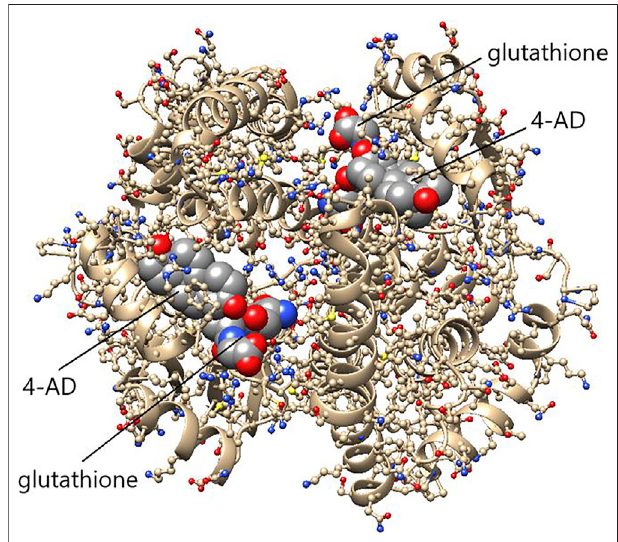
FIGURE8| Structure oftheef fi cientketosteroidisomeraseHsaGSTA3- 3 in a ternary complex with 4-androsten-3,17-dione (4-AD) and glutathione. The dimeric protein shows 4-AD bound in the H-site of each subunit in close proximity to glutathione in the G-site. The substrate 5-AD is assumed to bind essentially in the same pose as the product 4-AD shown. The structure indicates that the bulky substituent on C17 prevents 5-cholesten-3-one from binding as a substrate. (Figure based on the crystal structure PDB ID: